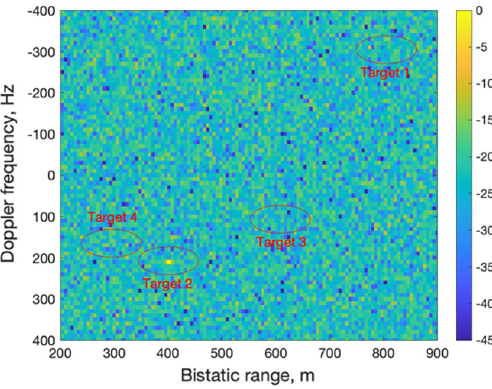
Fig. 4 Matched filter map of beam 1 with only DMI